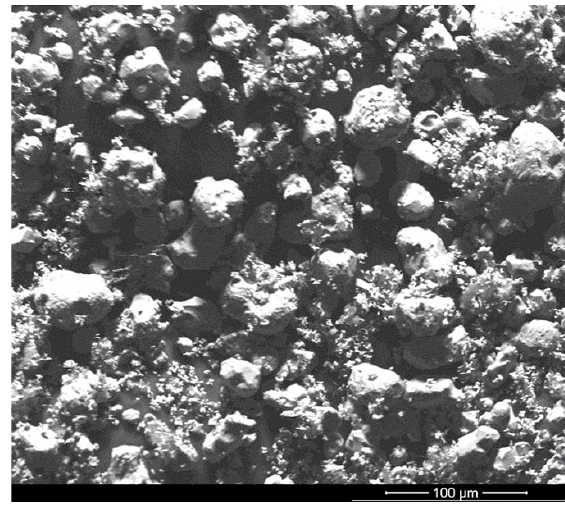
Figure 1. The microstructure of powder mixture.